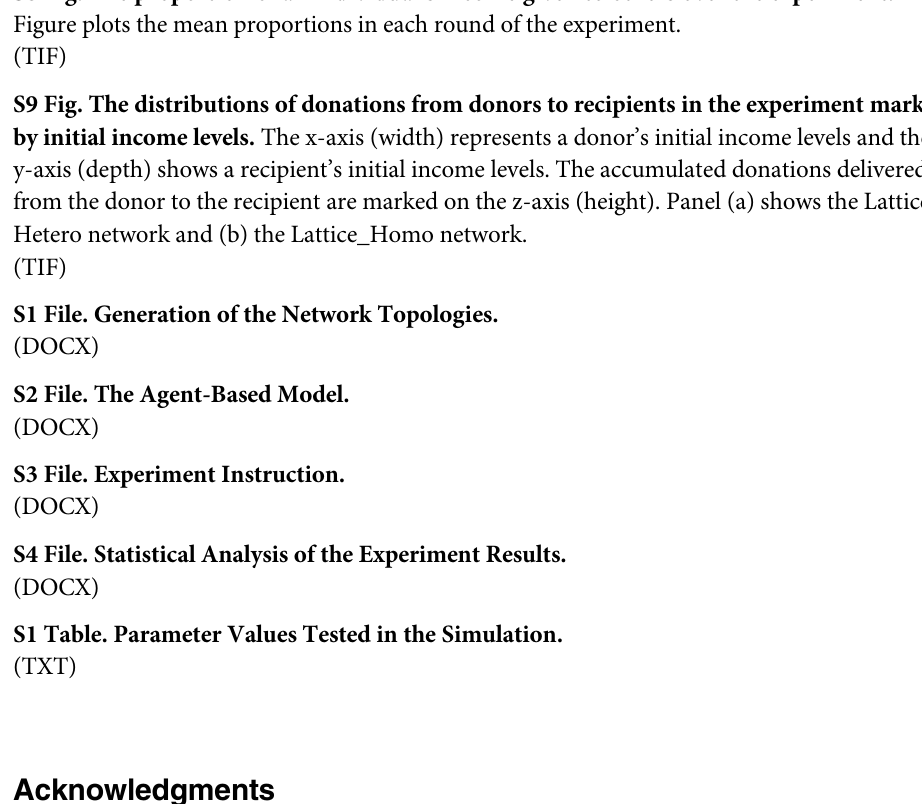
S5 Fig. The average inequality level (Gini coefficient) of the end-round distribution in the simulation tested against C K (light coral color) and C K ’ (light steel blue color). The shaded areas mark one standard error above and below the means. The horizontal dotted line shows the inequality level of the original distribution. (TIF) S6 Fig. The average inequality level (Gini coefficient) of the end-round distribution in the simulation tested against β 1 (light coral color) and β 2 (light steel blue color). The shaded areas mark one standard error above and below the means. The horizontal dotted line shows the inequality level of the original distribution. (TIF) S7 Fig. The proportion of participants that had donated in each round of the experiment. The values represent the mean proportions. (TIF) S8 Fig. The proportion of an individual ’ s income given to others over the experiment. The Figure plots the mean proportions in each round of the experiment. (TIF) S9 Fig. The distributions of donations from donors to recipients in the experiment marked by initial income levels. The x-axis (width) represents a donor ’ s initial income levels and the y-axis (depth) shows a recipient ’ s initial income levels. The accumulated donations delivered from the donor to the recipient are marked on the z-axis (height). Panel (a) shows the Lattice_- Hetero network and (b) the Lattice_Homo network. (TIF) S1 File. Generation of the Network Topologies. (DOCX) S2 File. The Agent-Based Model. (DOCX) S3 File. Experiment Instruction. (DOCX) S4 File. Statistical Analysis of the Experiment Results. (DOCX) S1 Table. Parameter Values Tested in the Simulation.